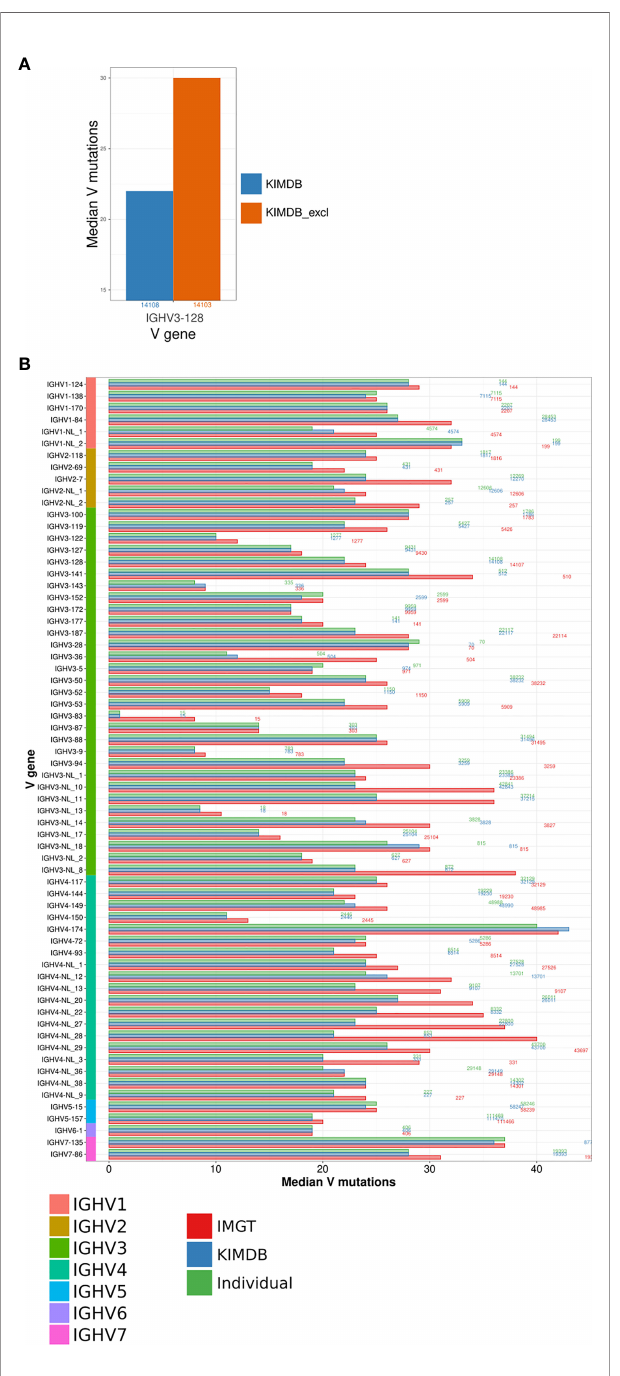
FIGURE 3 | Evaluation of the number of mutations from germline using different databases. (A) Comparison of differences in the estimation of SHM using the full KIMDB, marked in blue and KIMDB_excl, a version of KIMDB that has all alleles of the gene IGHV3-128 removed, marked in orange. (B) IgG sequences from the D20 animal were assigned to the animal ’ s individual IGHV database, shown in green, KIMDB, shown in blue, or the IMGT rhesus macaque database, shown in red. The average number of mutations in the IGHV sequence after assignment to each of the databases is shown by the median V mutations count. The numbers to the right of each set of gene speci fi c bars indicate the number of reads for that gene in the IgG library.